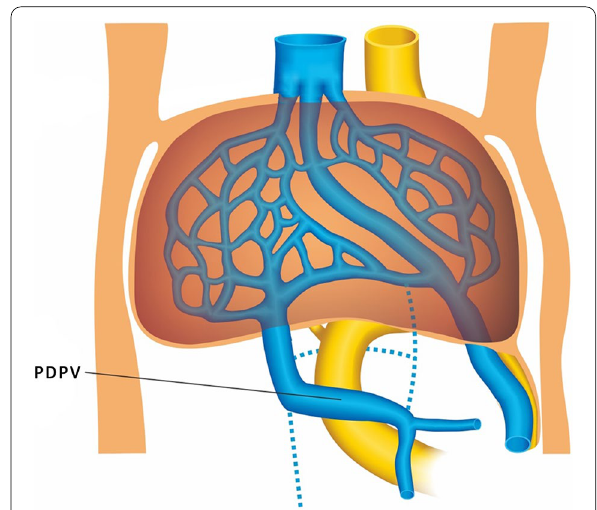
Fig. 3 The embryological scheme of PDPV. At the embryonic development, dorsal anastomose of the VVs degenerates and caudal-ventral anastomose persists forming PDPV